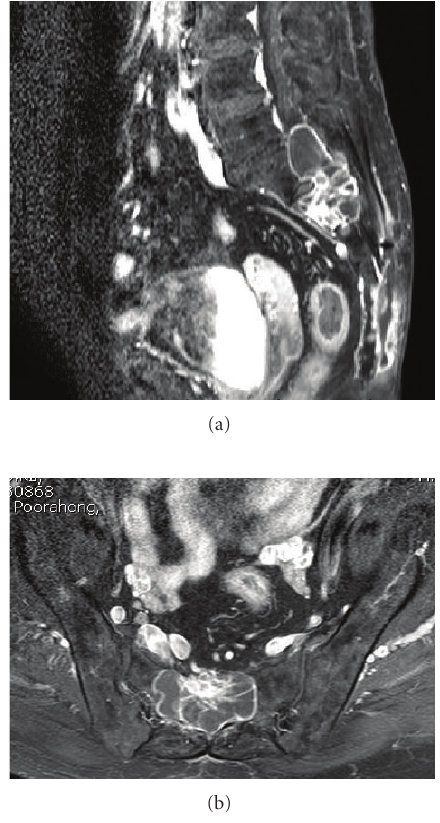
Figure 3: Sagittal (Figure 3(a)) and axial (Figure 3(b)) T1- weighted/GD/FS MR images show a well-defined extradural cystic mass with multiple enhanced septations and thin enhanced solid nodule, originating from the posterior aspect of S1–S3